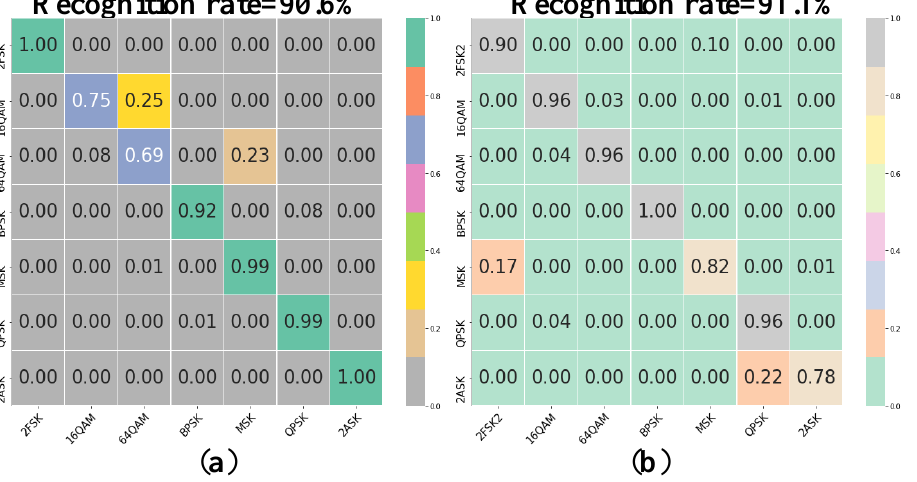
Figure 10. Experimental results on signal dataset 1 in which the signal parameters to be recognized are consistent with those of the training set. ( a ) Original sampling waveform. ( b ) Time-frequency map.